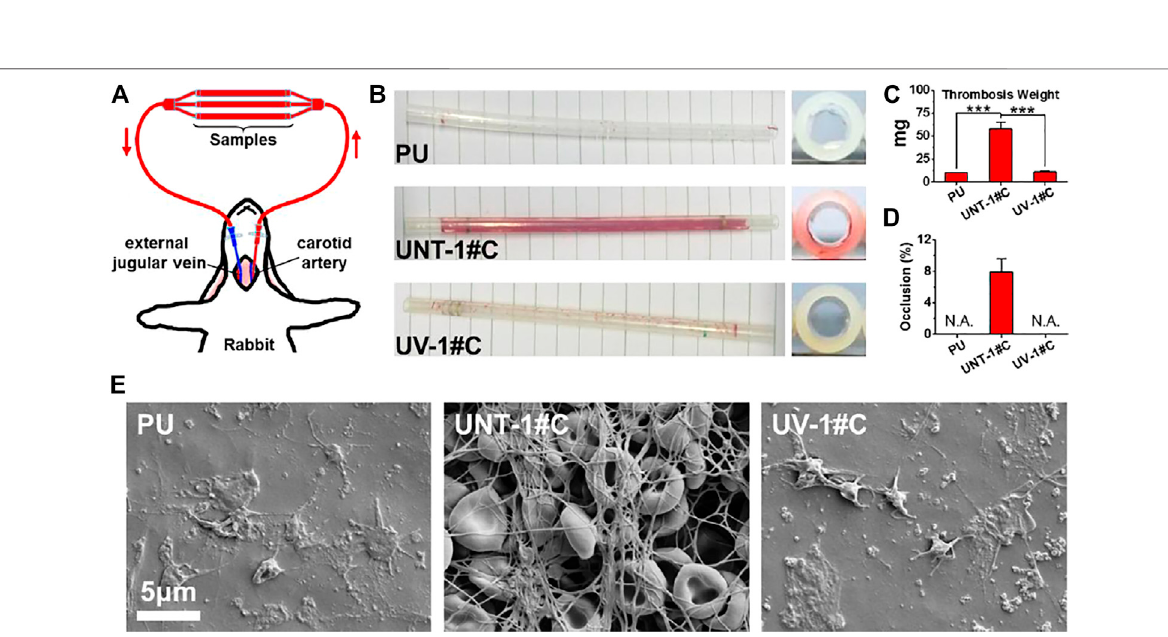
Frontiers in Bioengineering and Biotechnology |